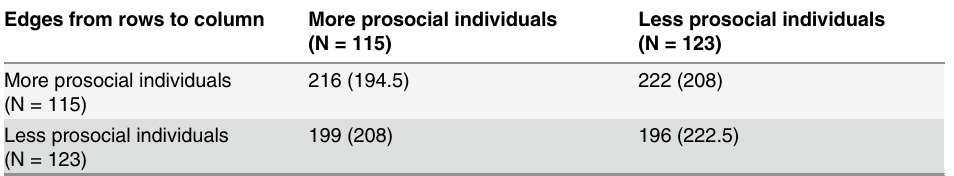
Table 4. Mixing matrix between different levels of prosociality. Edges from rows to column More prosocial individuals Less prosocial individuals (N = 115) (N = 123) More prosocial individuals 216 (194.5) 222 (208) (N = 115) Less prosocial individuals 199 (208) 196 (222.5) (N = 123) Numbers outside and within parentheses are observed and expected numbers of friendship, respectively. Expected numbers of edges are the product of three numbers: 1) proportion of subgroup where the friendship is named from, 2) proportion of subgroup where friendship is directed to, and 3) total number of friendship (833). For example, the expected number of friendship among more prosocial individuals is 194.5 (=